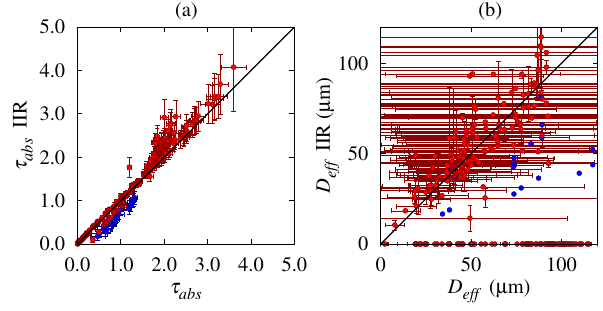
Fig. 8. Similar to Fig. 6, for 18 October